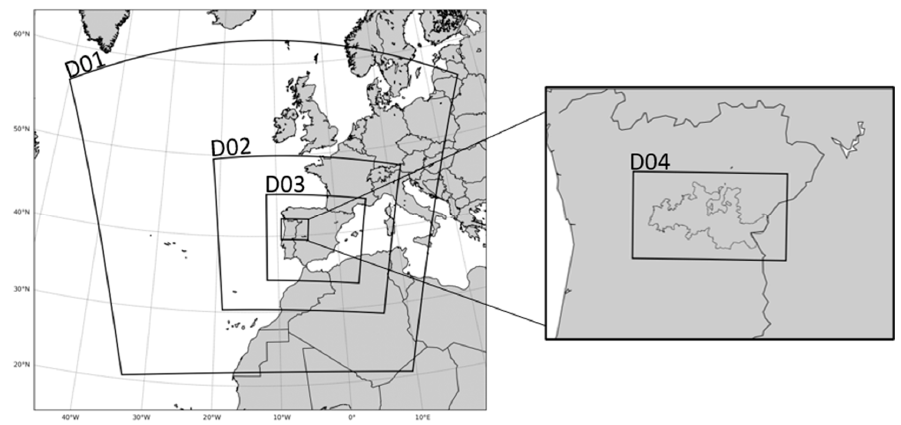
Figure 3. Simulated domains with the WRF-CHIMERE modelling system. (Spatial resolution: 81 km (D01), 27 km (D02), 9 km (D03) and 1 km (D04). Table 2. Ranked Douro Demarcated Region (DDR) annual temperature (1 April–30 September) based on the Weather Research and Forecasting (WRF) model results (9 km resolution) forced by ERA-Interim for the period 1986–2005. Years in bold were selected for the